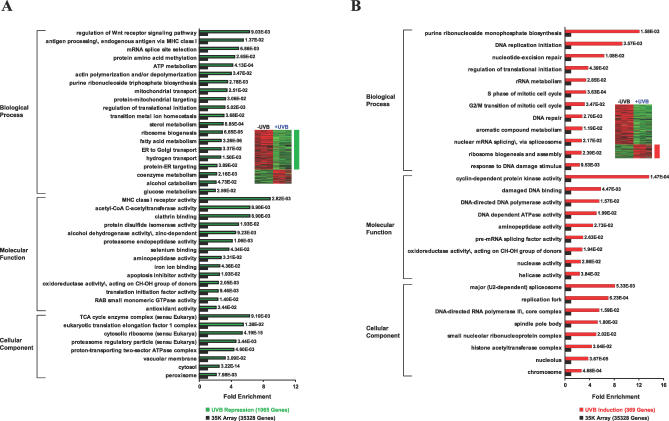
Over-Representation Analysis of Functional GO Terms for UVB-Responsive Genes in the Basal Epidermis of Normal (+/+) P2.5 MiceEASE software [48] was used to map GO terms to (A) 1,065 UVB-repressed (green bars) and (B) 369 UVB-induced (red bars) genes. GO terms that were significantly enriched (p = 0.05), by 2-fold, relative to all of the assayed genes on the 35,000 array (35,328 genes) (black bars) and that contained at least three gene hits, are displayed. GO terms are ranked, within high-level GO branches, by fold-enrichment relative to the 35,000 array. A thumbnail image provides a reference for each of the analyzed UVB response classes.